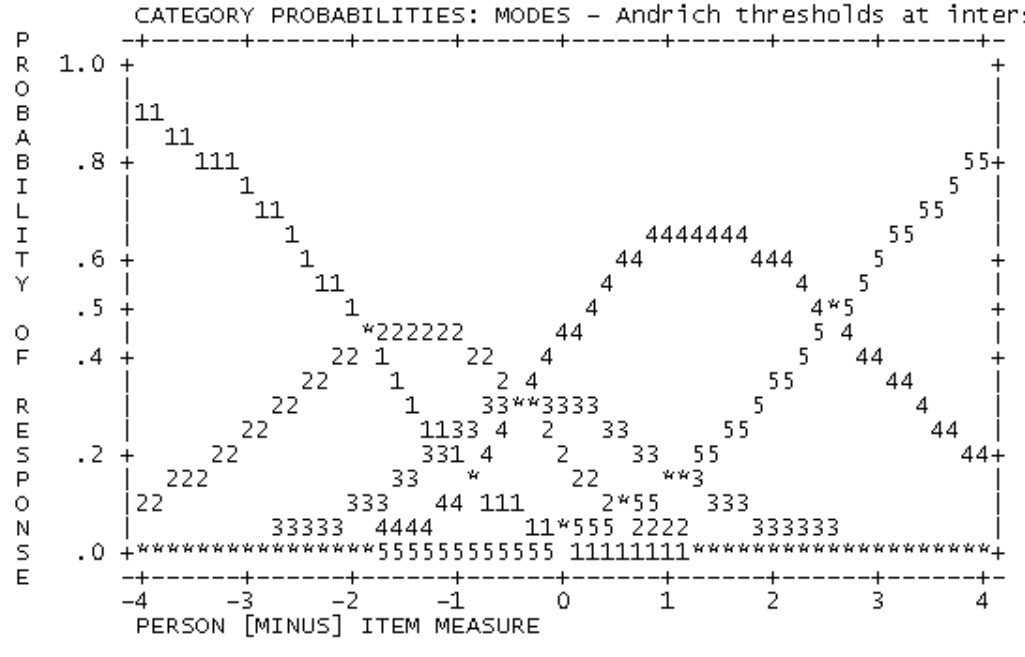
Figure 2 . Response category probability curves.